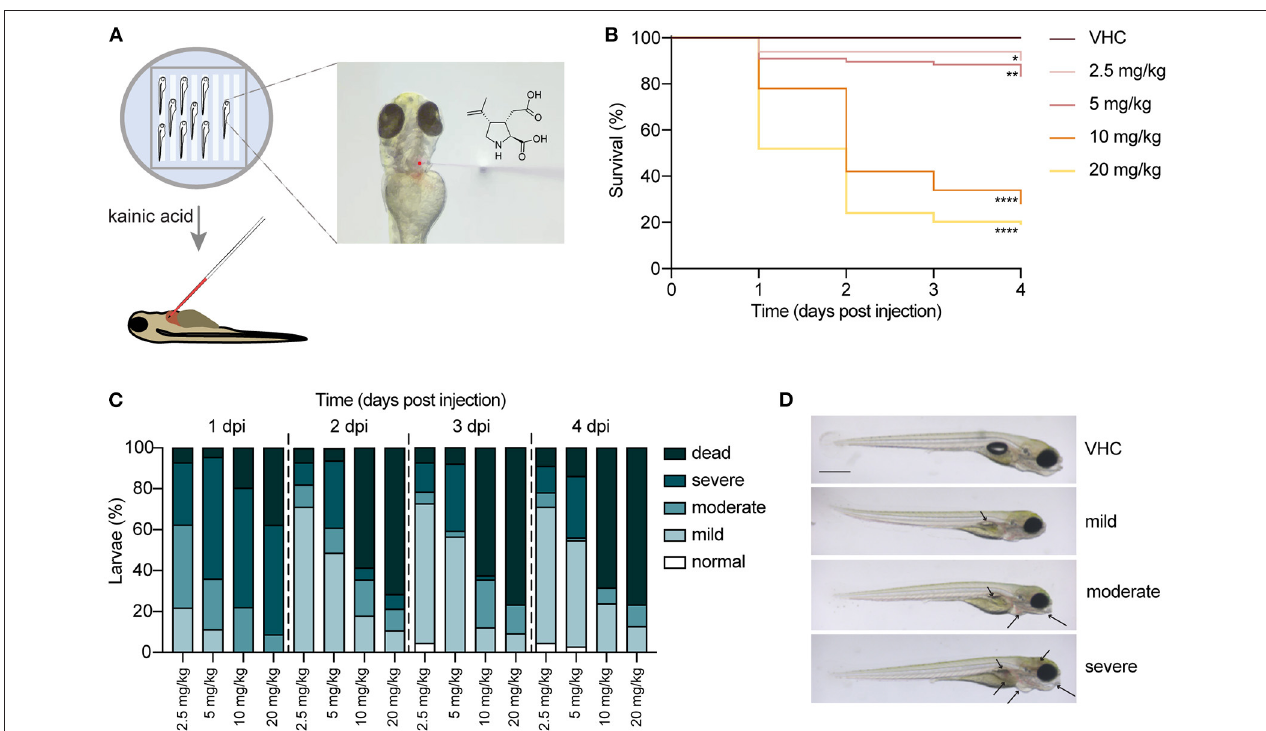
FIGURE 1 | Injection of kainic acid into the bloodstream of 3 days post fertilization (dpf) zebrafish larvae. (A) A scheme of the set-up of kainic acid (KA) injection into 3 dpf zebrafish larvae. The larvae were anesthetized in 0.4 mg/mL tricaine and aligned in an agarose mold (left panel). KA mixed with dextran rhodamine B used as a tracer was injected into the zebrafish pericardium (right panel). (B) Survival of the larvae injected with 2.5, 5, 10, 20 mg/kg KA and vehicle (VHC) as a control. Significant larval death can be observed in a time-dependent manner. Statistical analysis between different doses injected was performed using Log-rank (Mantel-Cox) test (* p < 0.05, ** p < 0.01, **** p < 0.0001). Data pooled from three independent experiments, total numbers include: VHC n = 60, KA 2.5 mg/kg n = 50, KA 5 mg/kg n = 84, KA 10 mg/kg n = 61, KA 20 mg/kg n = 83. (C) Quantification of morphological abnormalities after injection of 2.5, 5, 10 and 20 mg/kg of KA from 1 until 4 days post injection (dpi). Larval phenotype was classified in function of number of malformations—normal, mild, moderate and severe. The graphs include the percentage of dead larvae. Data were pooled from three independent experiments, total numbers include: VHC n = 60, KA 2.5 mg/kg n = 50, KA 5 mg/kg n = 84, KA 10 mg/kg n = 61, KA 20 mg/kg n = 83. (D) Representative images of KA-injected larvae showing normal, mild, moderate and severe phenotypes. Mild or moderate abnormalities included predominantly lack of swim bladder, while severe abnormalities consisted of jaw malformation, pericardial edema and yolk